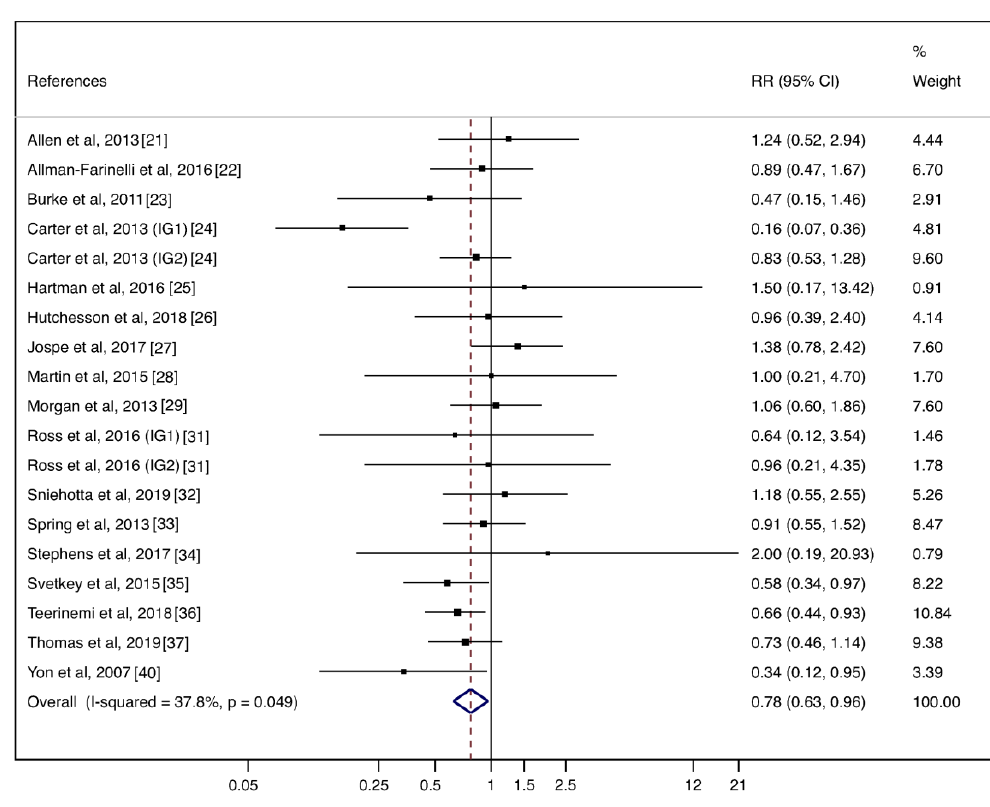
Figure 3. Forest plots of the pooled relative risk for the adherence of behavioral weight management interventions using lifestyle mHealth self-monitoring.